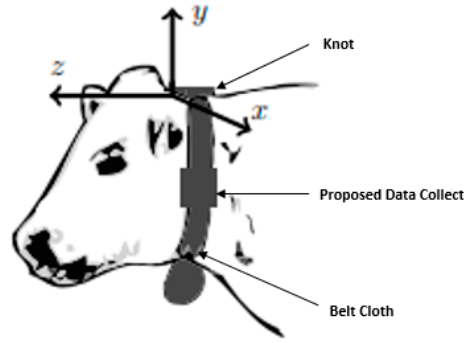
Figure 9. Location attachment for the proposed data collector on the forehead of cattle.